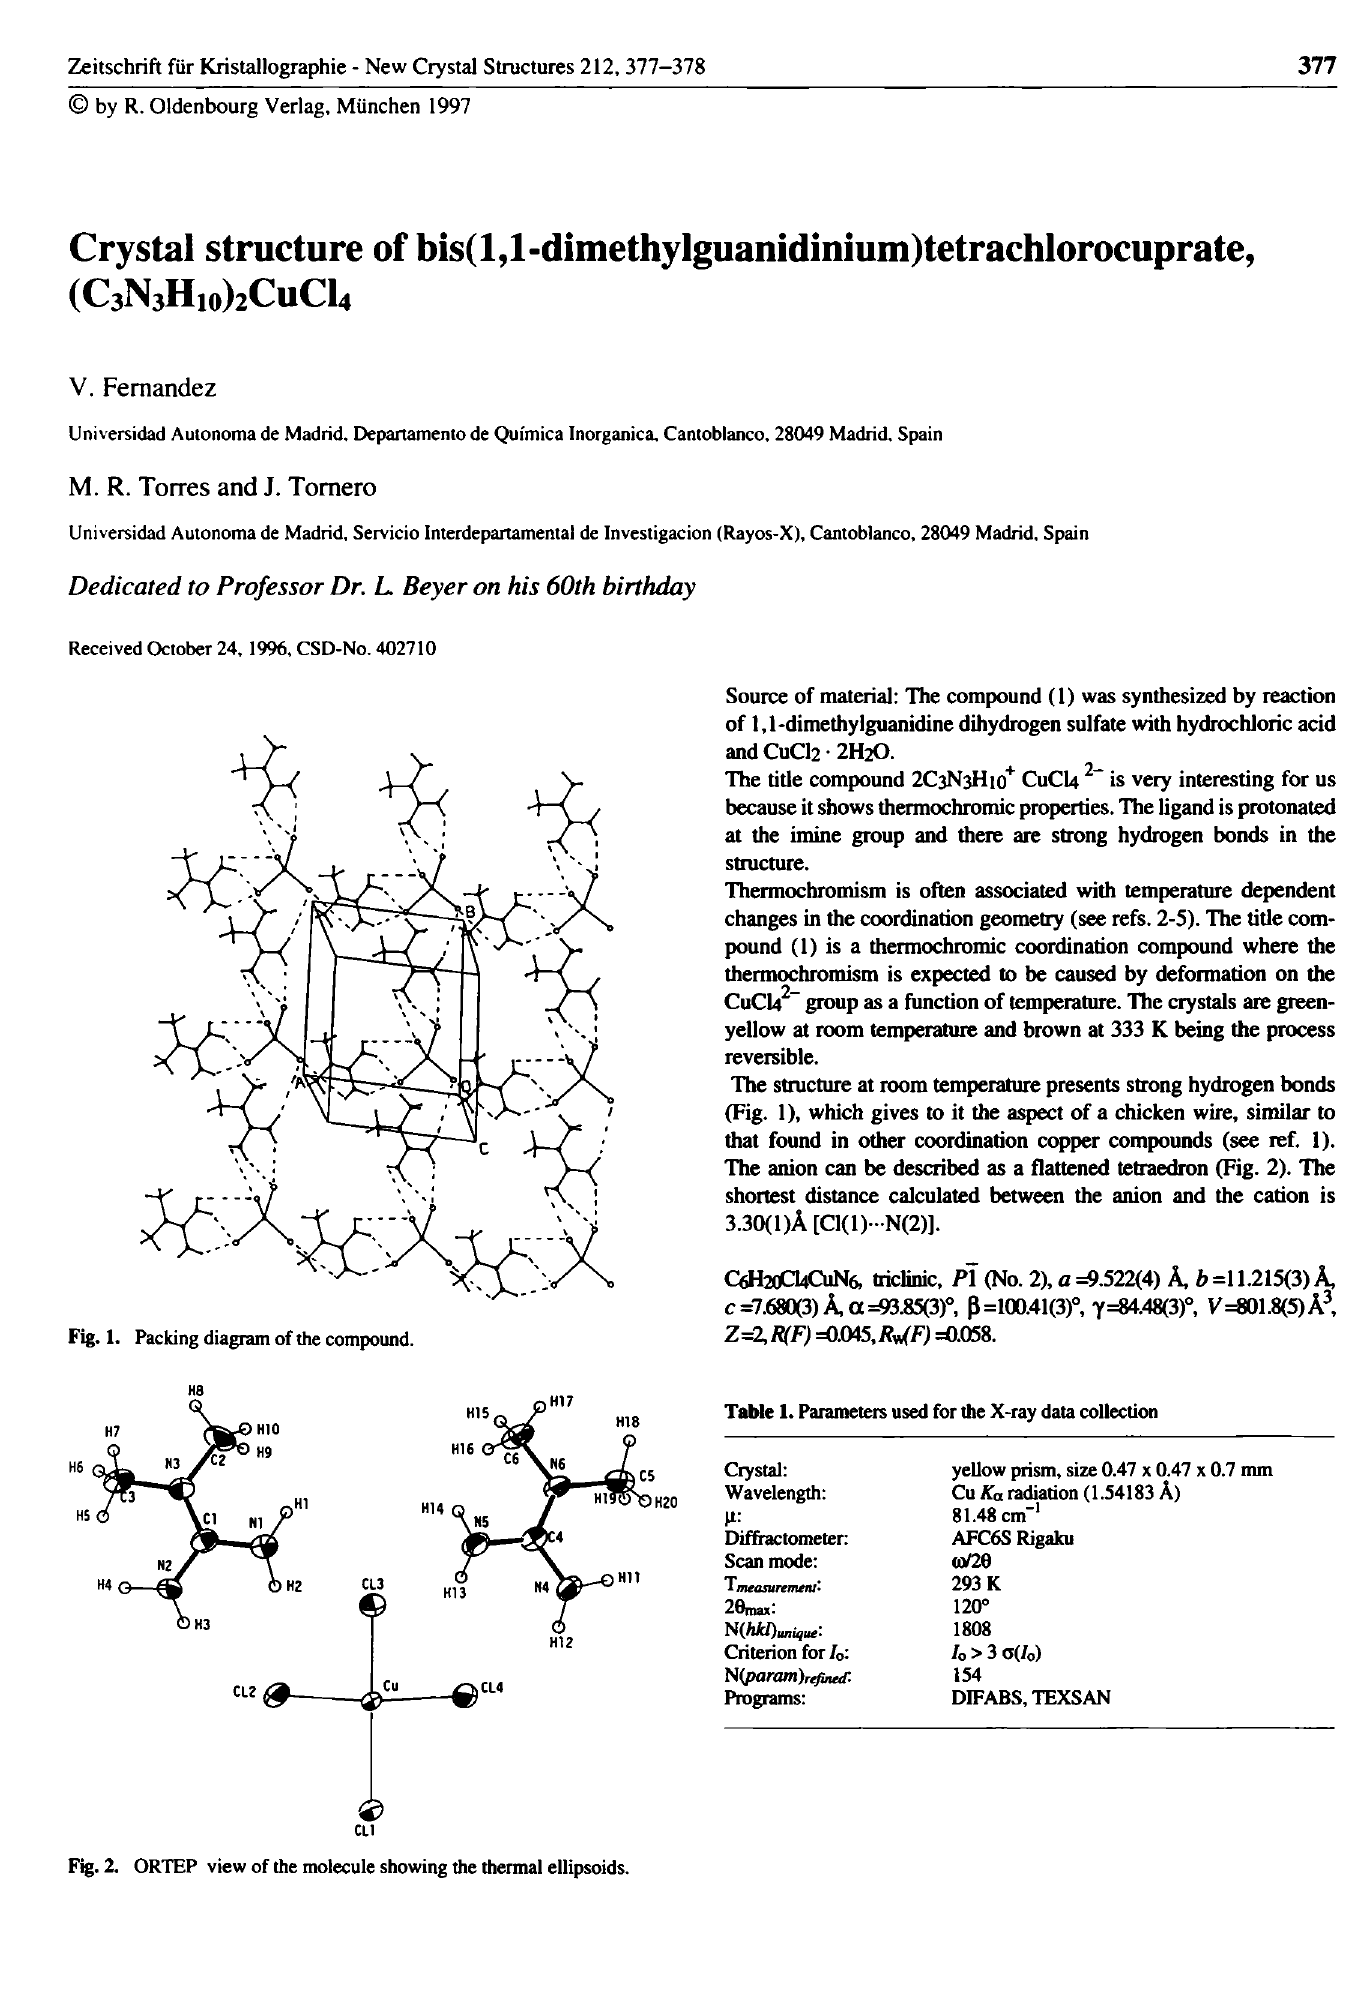
Fig. 2. ORTEP view of the molecule showing the thermal ellipsoids.